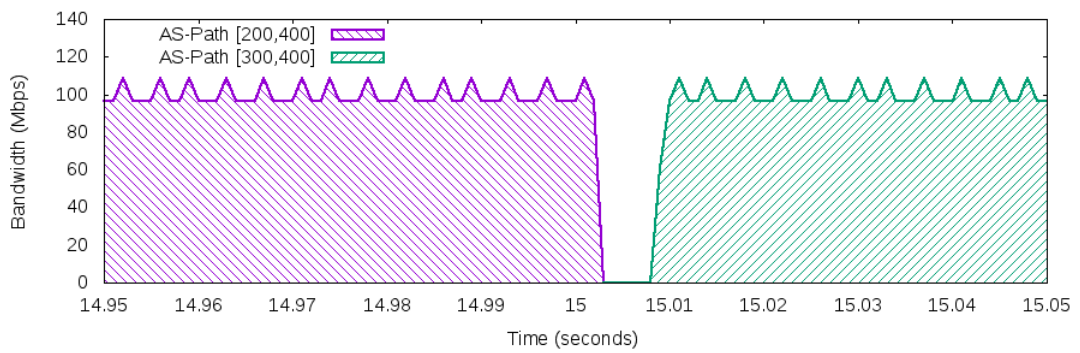
Figure 12. Details of network traffic for the link failure around the 15th